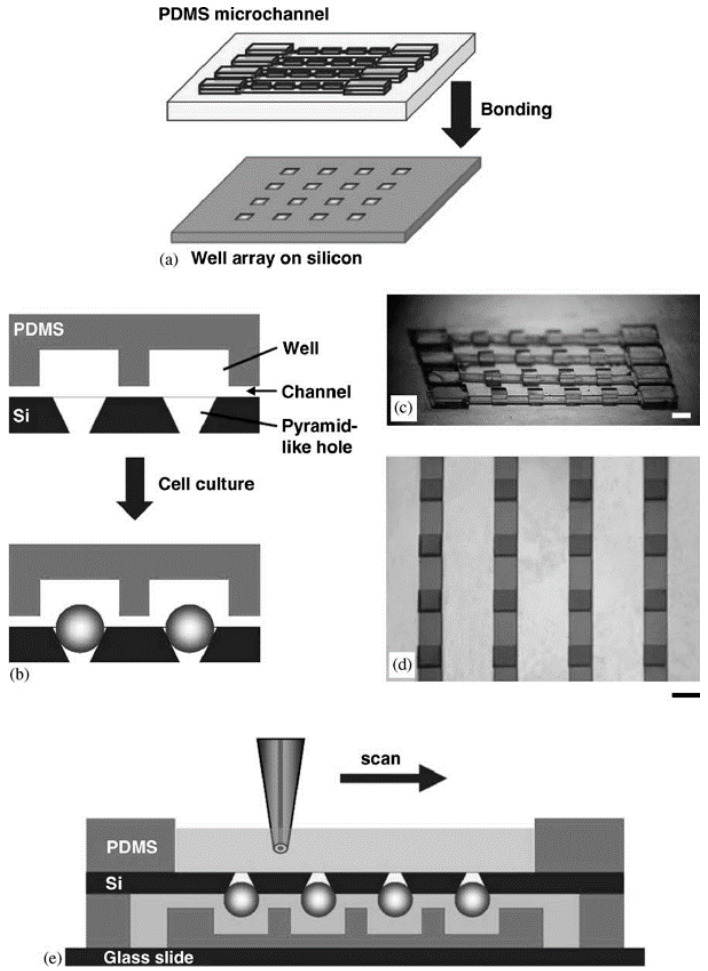
Figure 2. A schematic illustration of the concept ( a ) and cross-section ( b ) of the spheroid chip. Polydimethylsiloxane (PDMS) microchannels and the array of wells were bound to a silicon substrate. ( c ) The master mold for fabricating PDMS microchannels using two-step photolithography. ( d ) The fabricated microchannels which were attached to the glass substrate. ( e ) The tip scanned over the spheroid for measurement. The scale bar is set at 1 mm. (Reproduced from Reference